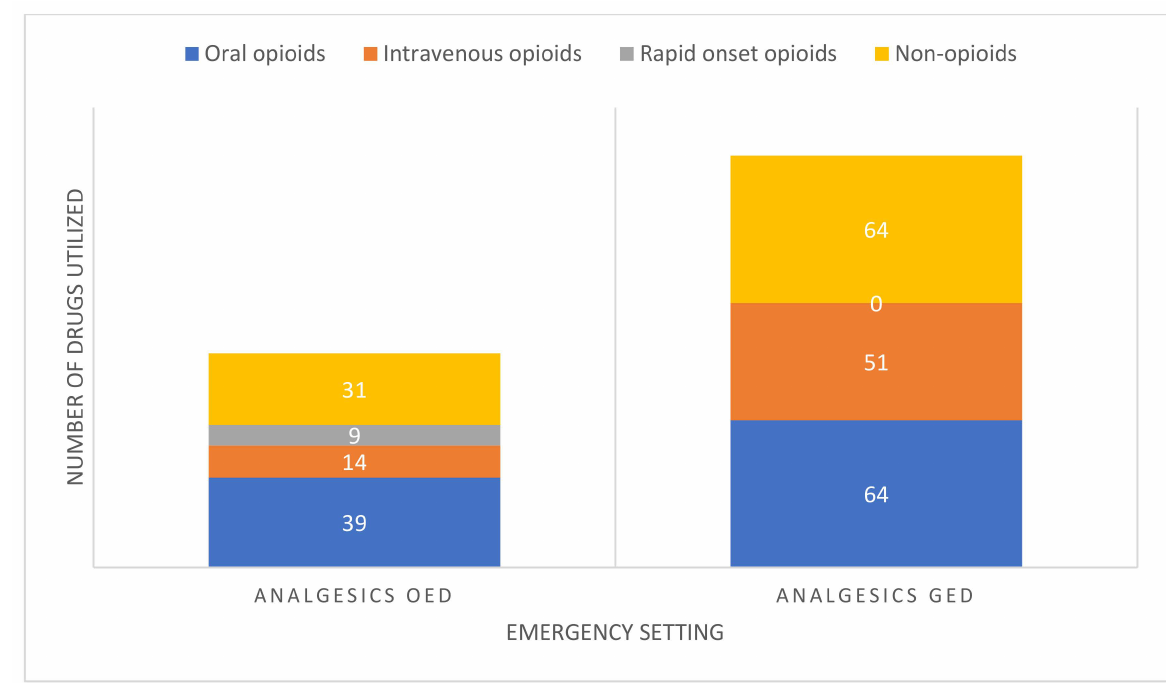
Figure 2. Title: Analgesic utilization in GED and OED. Legend: Among the analgesics, the use of oral opioids, intravenous opioids and rapid onset opioids in OED was significantly different from GED ( p < 0.001, p = 0.003, p = 0.003, respectively). GED—General emergency department;